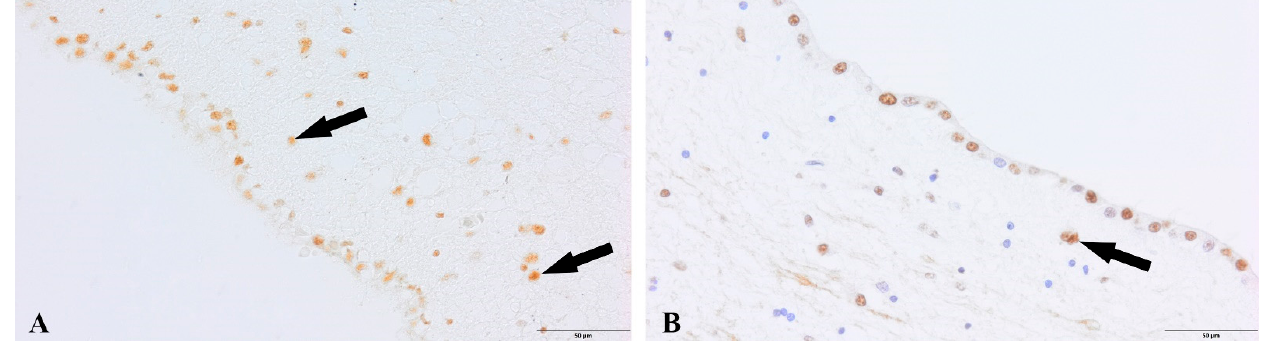
Figure 3. Subventricular zone, neural progenitor cells (NPCs, arrows). ( A ). Control group. ( B ). Group patients with diagnosed COVID-19. Immunolabeling p-Histone H3Ser10 antibody.